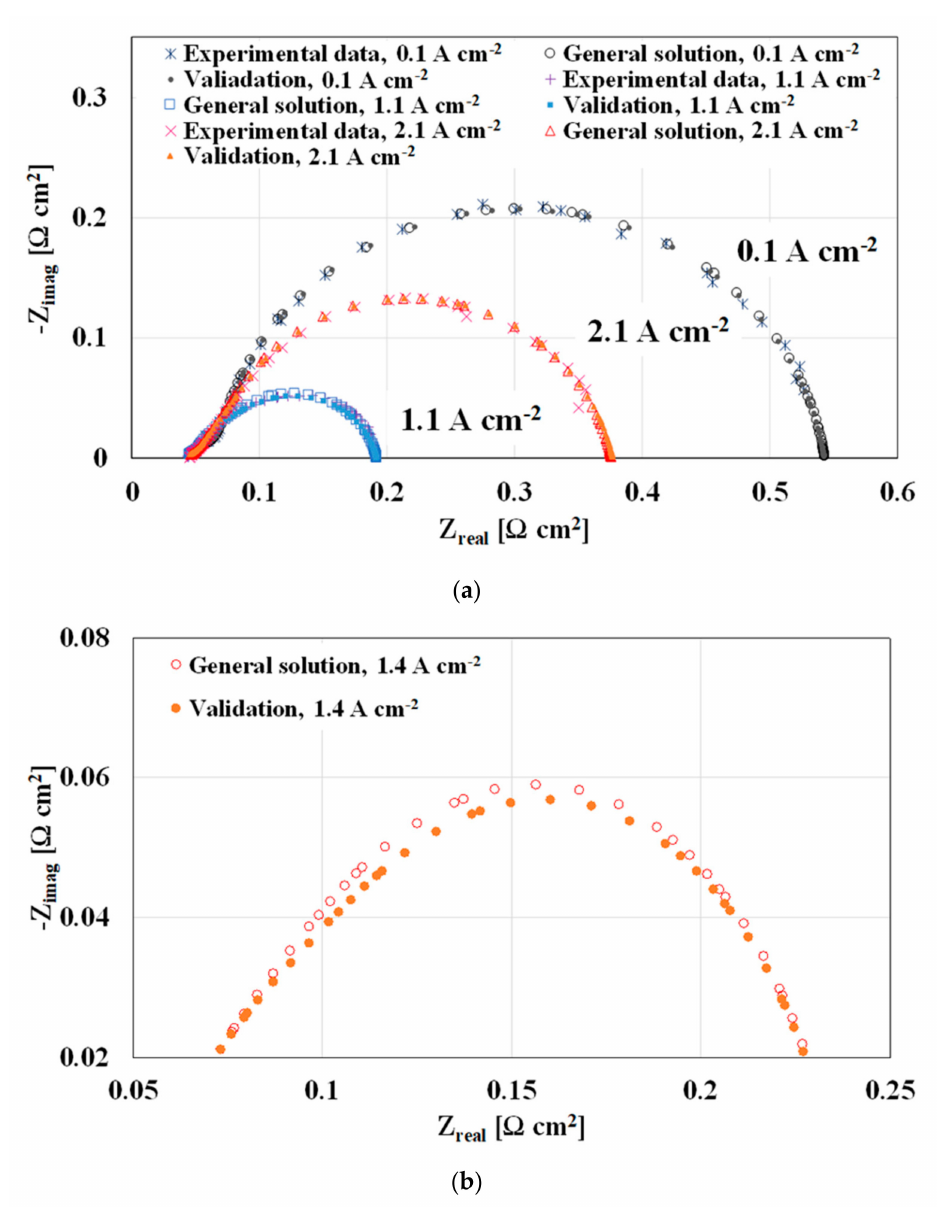
Figure 4. ( a ) Nyquist plots are plotted at relative humidity (RH) 100%, ( b ) RH 50% under H 2 /air condition. Open symbols represent general solution and closed symbols represent validation model. Cross symbols represent experimental